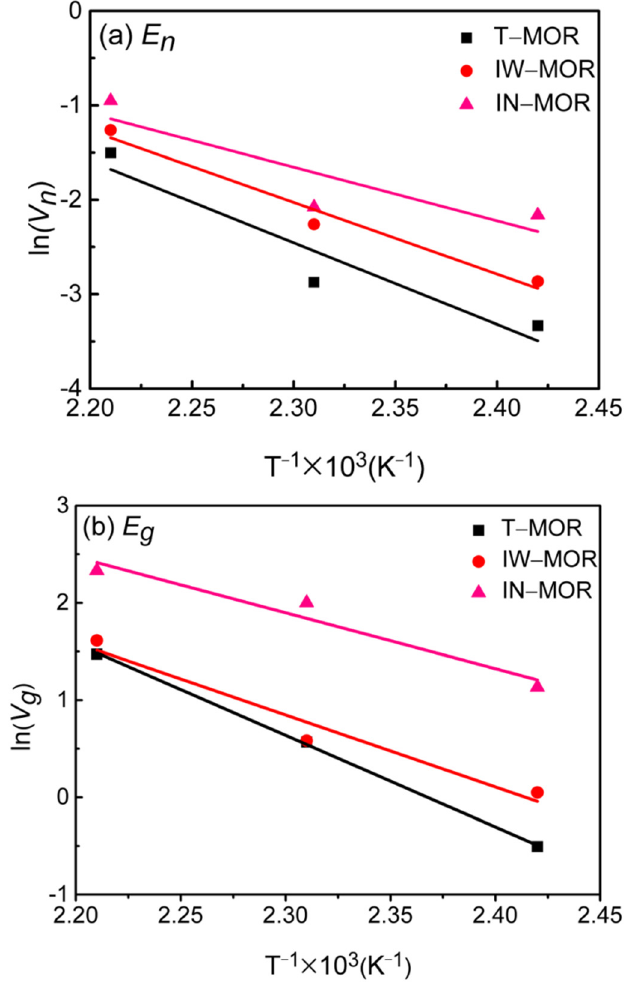
Figure 8. Arrhenius plot for the ( a ) nucleation activation energy E n and ( b ) crystal growth activation energy E g .